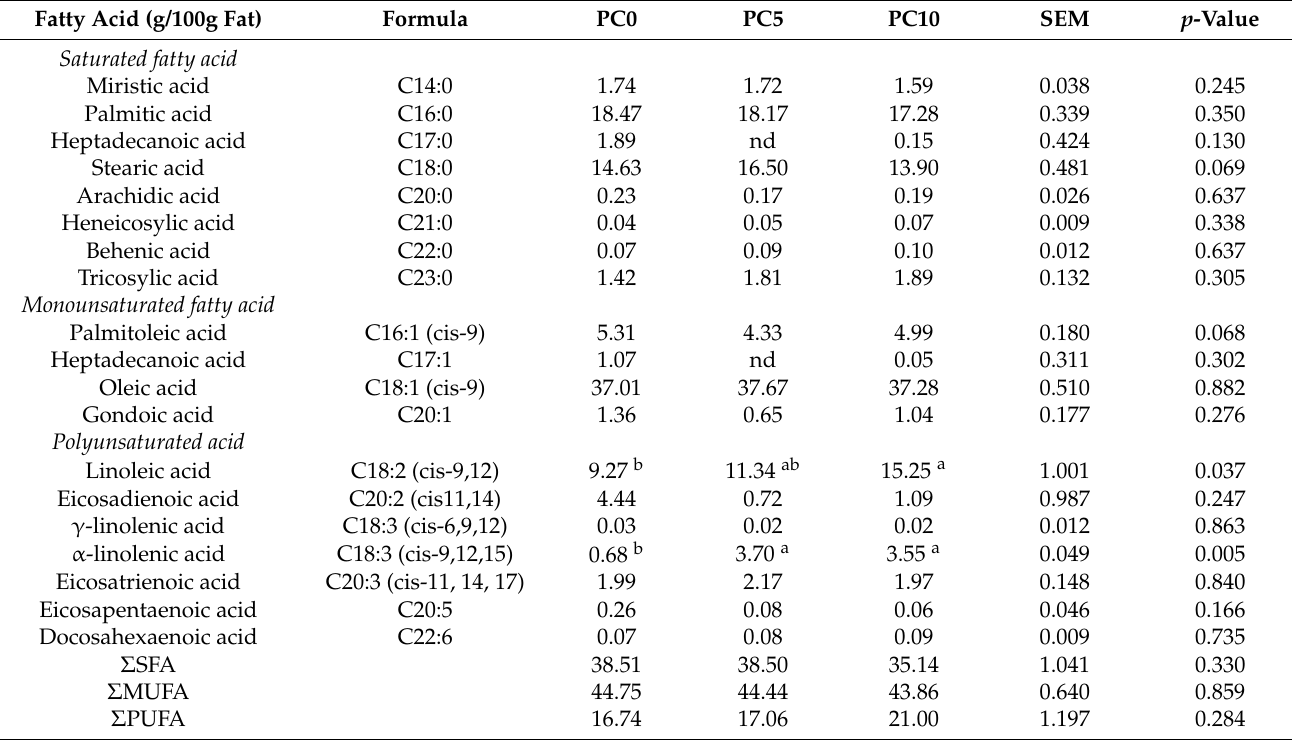
Table 6. Effect of dietary perilla cake supplementation on the fatty acid profile in the backfat of growing pigs. Fatty Acid (g/100g Fat) Formula